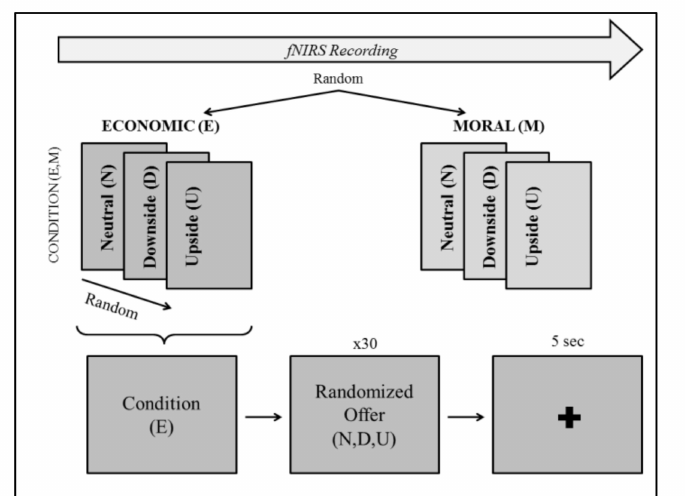
Figure 1. Schematic representation of the structure of the adapted version of the UG used. While fNIRS was recording, Economic (E) and Moral (M) conditions randomly appeared on the computer. Each of them included three di ff erent o ff ers (i.e., Neutral (N), Downside (D), Upside (U)) presented in a random order (30 times each, 90 times in total for each condition), which were asked whether to accept or reject those o ff ers. After a decision had been made, a cross appeared in the middle of the screen for 5 s. A short break separated the two